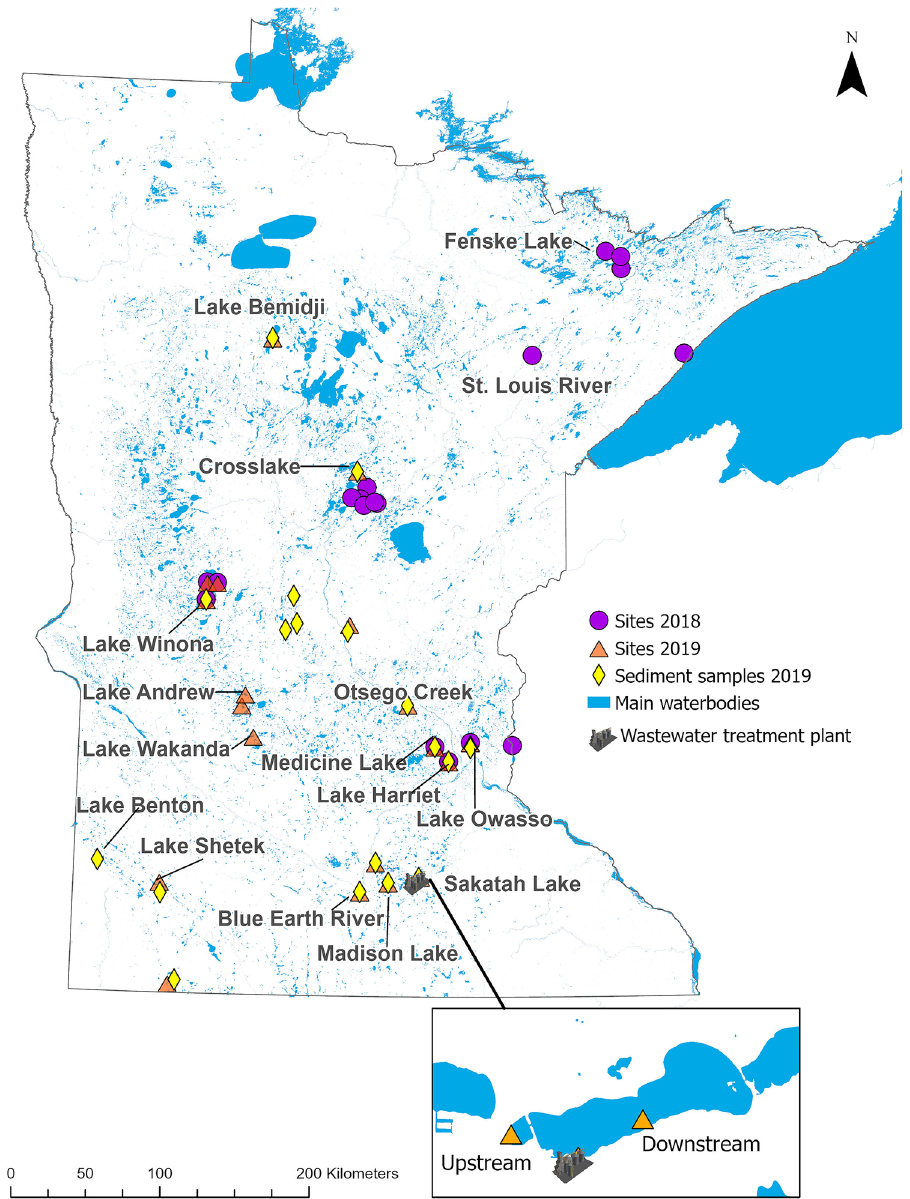
Figure 4. Map of Minnesota with sampling sites for each one of the sample types. The map shows the sampling at the macroscale, and an example of one of the sites with influence of a wastewater treatment plant where there was sampling conducted at the microscale. This figure also captures the names of the sites with highest antimicrobial concentrations and ARG